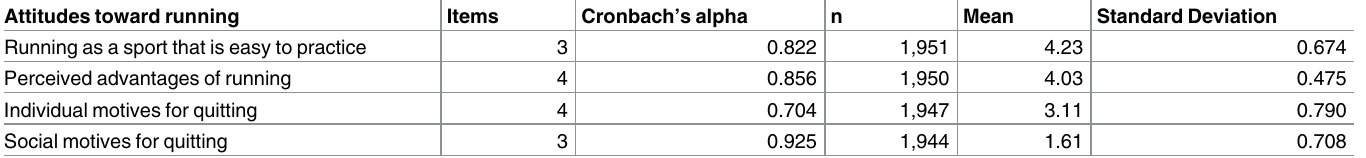
Table 2. Overview and descriptive statistics of the psychographic